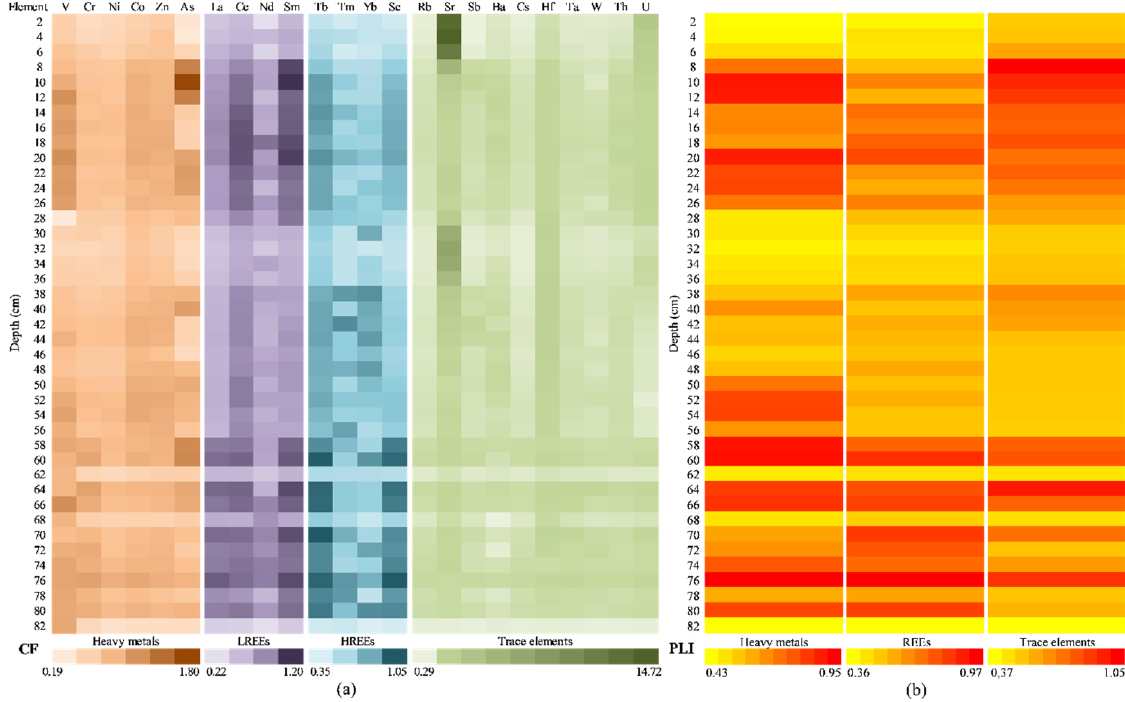
Figure 16. Contamination factors (CFs) ( a ) and pollution load indices (PLIs) ( b ) calculated from the Caineni Lake sediment core (82 cm depth).